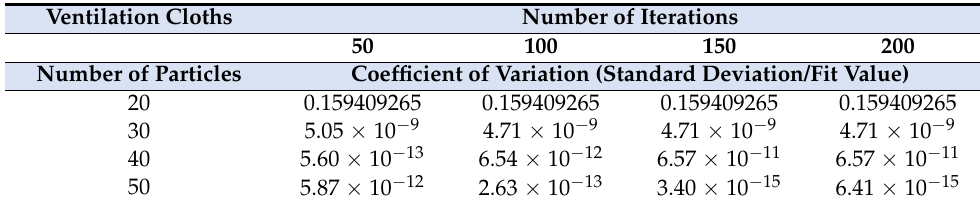
Table 5. Optimization of acoustic resistance of ventilation cloths, particle number, and coefficient of variation (Remarks: The upper and lower boundaries are in the range of 10 times the original parameter value (10~0.1)).